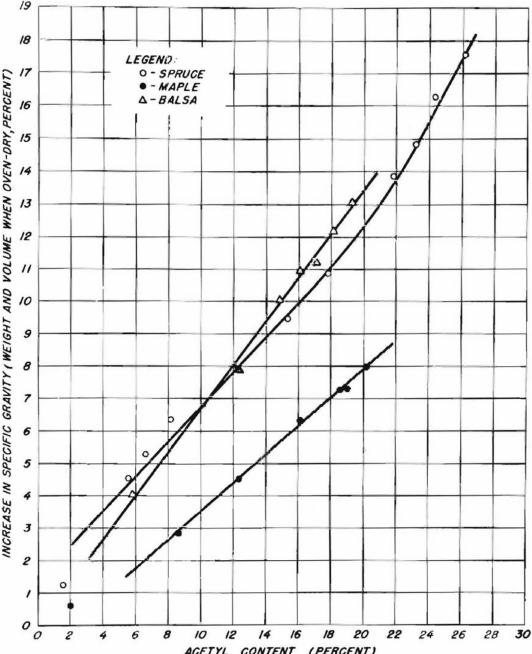
Figure 4. Relationship between the acetyl content and the percentage increase in specific gravity [7]. Figure 5 shows the relationship between the volume of acetyl groups per gram and ASE acetylated, butylated, and propionylated spruce. All three types of esterification fit the same curve. Again, there was a proportional relationship up to about 0.25 cc/g of